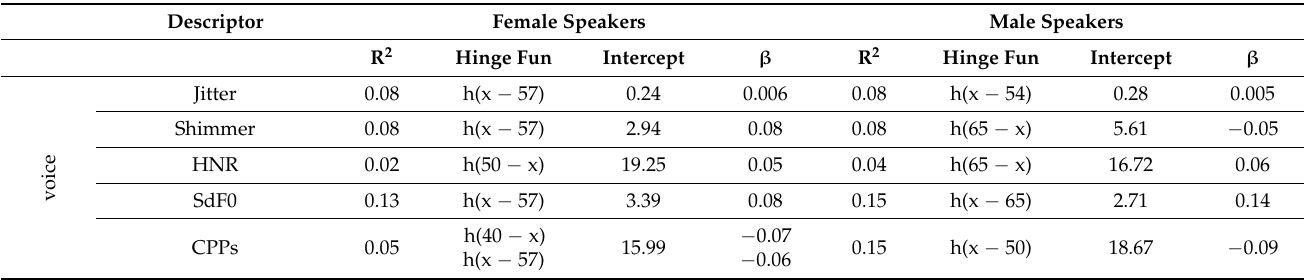
Figure 2. ArticRate ( y -axis) as a function of age ( x -axis) in speakers with the hinge function (red curve) of MARS models for Male ( left ) and Female ( right ) speakers. Table 3. Summary of the 44 (22 × 2) MARS models of analysis 1, testing how each of the 22 variables is modeled by age, for female (left panel) and male (right panel) speakers separately. Each model and associated hinge function(s) are described in terms of: R 2 values (as a measure of the explicative power of the model); hinge function (hinge fun, h(x − a) or h(a − x), where a is the cut-point value or knot and x is age) *; the intercept of the model; the slope estimate ( β ) of the functions.